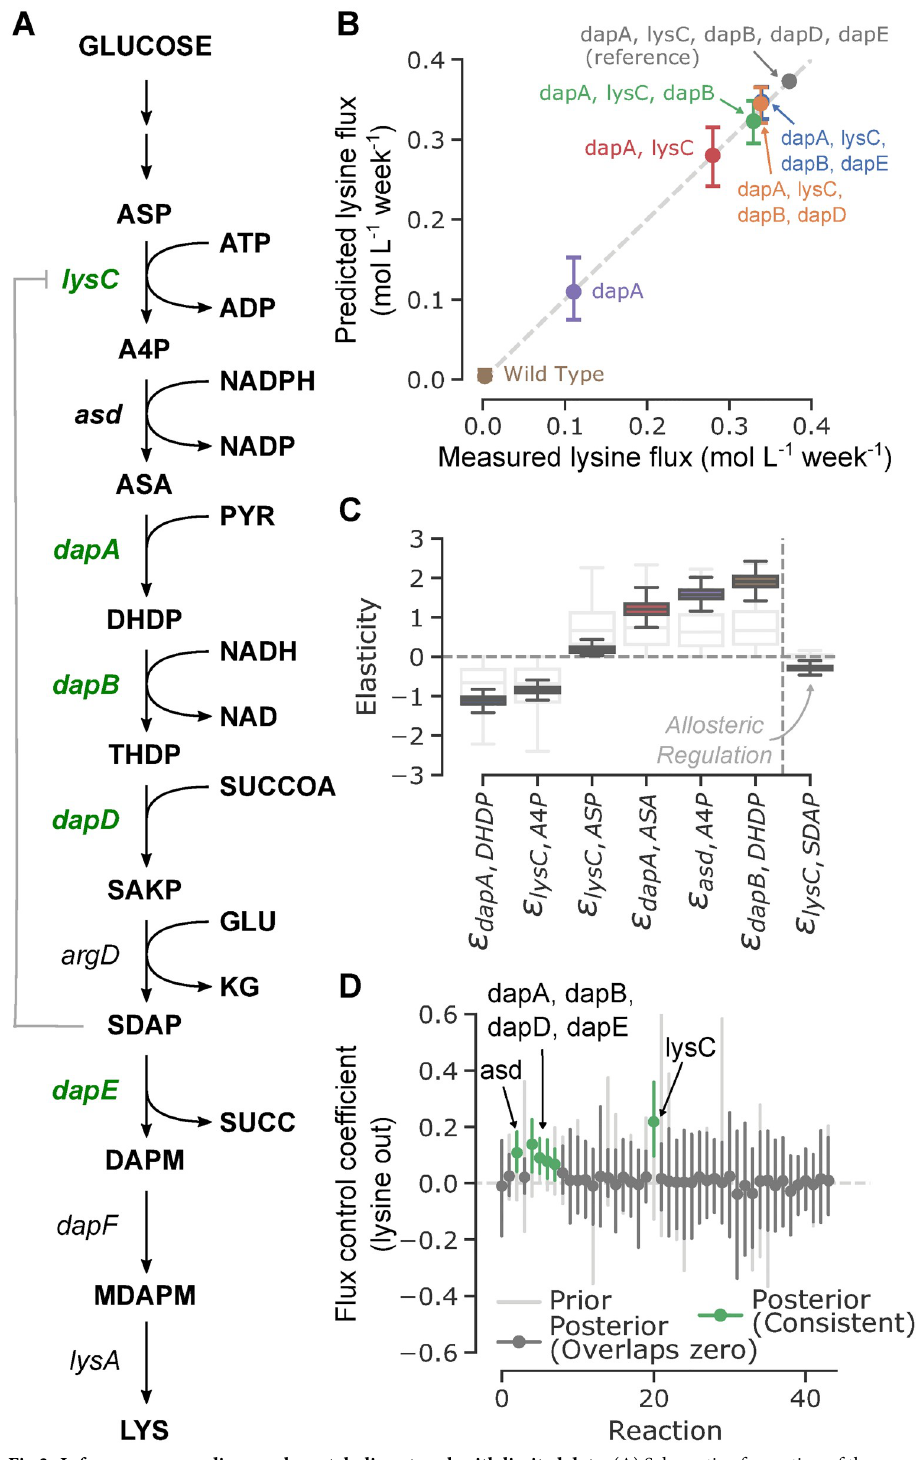
Fig 3. Inference on a medium-scale metabolic network with limited data. (A) Schematic of a portion of the considered metabolic network corresponding to lysine biosynthesis. Reactions shown in green were experimentally determined to improve lysine yields. The allosteric regulation of lysC by SDAP (N-succinyl-L,L-2,6-diaminopimelate) inferred by the model is shown in gray. (B) Experimental vs posterior predictive distributions for lysine flux. Error lines extend to cover the 95% highest posterior density (HPD) interval. (C) Distributions of elasticities informed by the